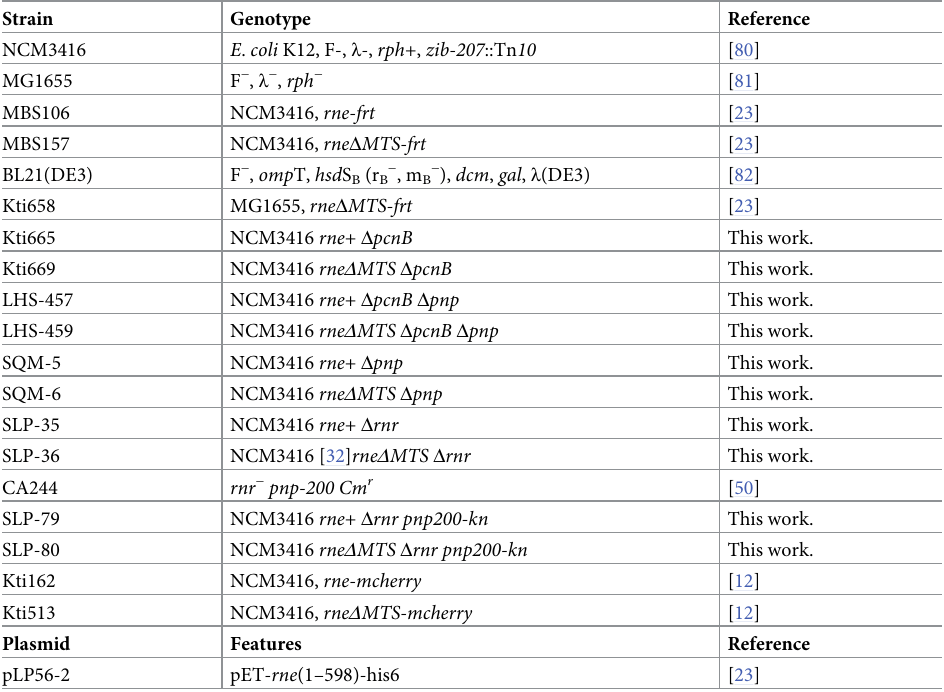
Table 1. Strains and plasmids.